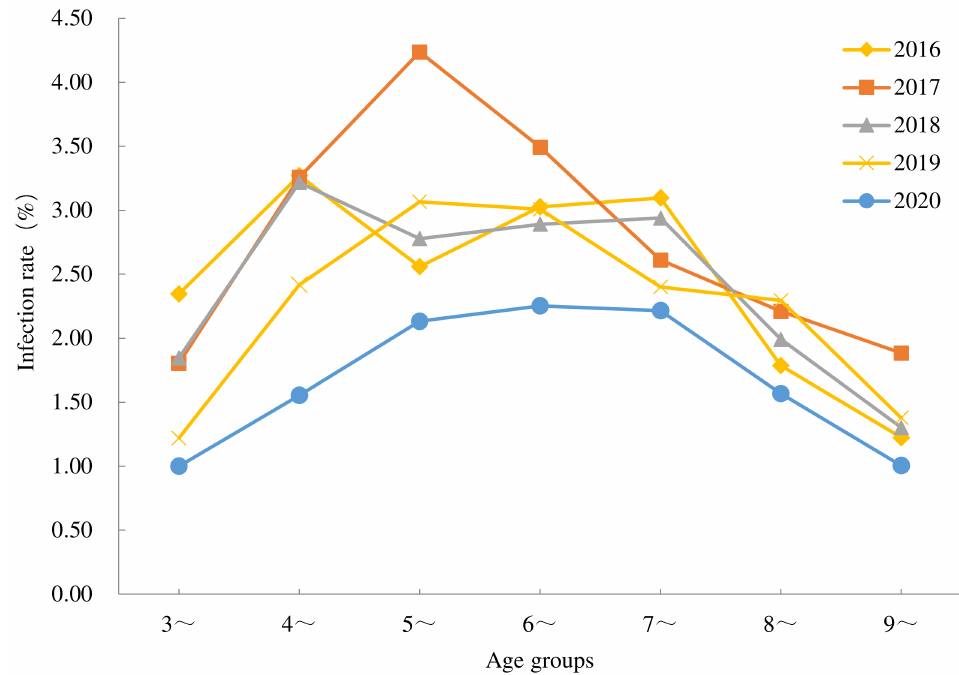
Figure 2. Enterobius vermicularis infection among children by ages in China from 2016 to 2020. The difference in infection rate was significant among ages in each year ( χ 2 values of 70.32, 112.62, 79.89, 128.73 and 84.33, respectively, with P < 0.0001).